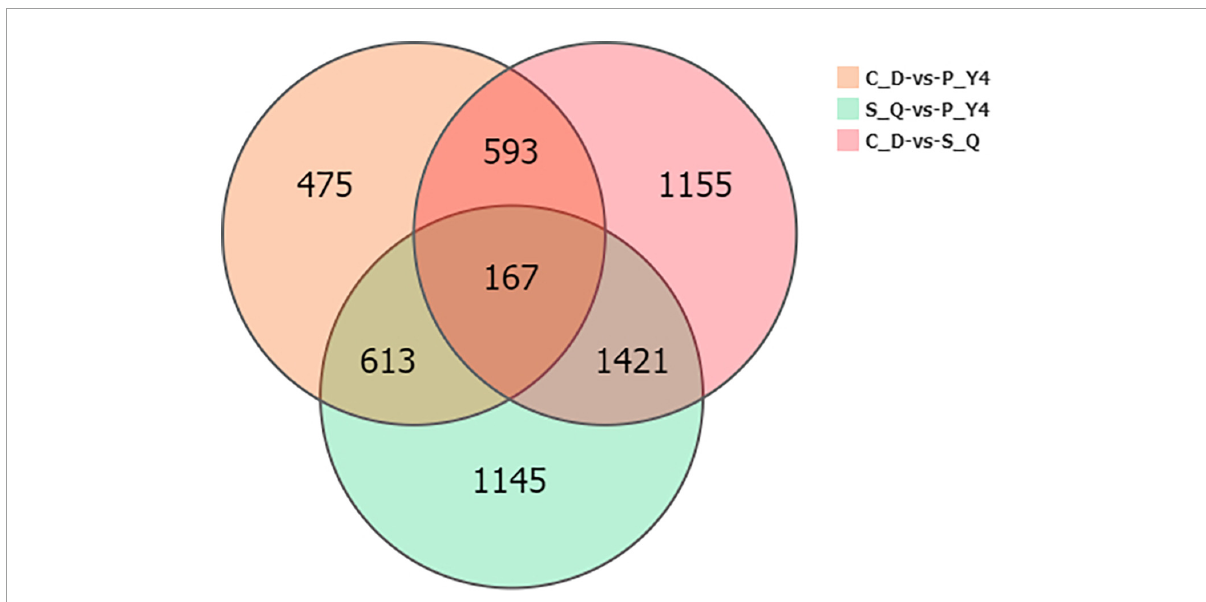
FIGURE8 The Venn diagram of differentially expressed genes (DEGs) by comparing P-Y4 vs. C-D, S-Q vs. C-D, and P-Y4 vs.